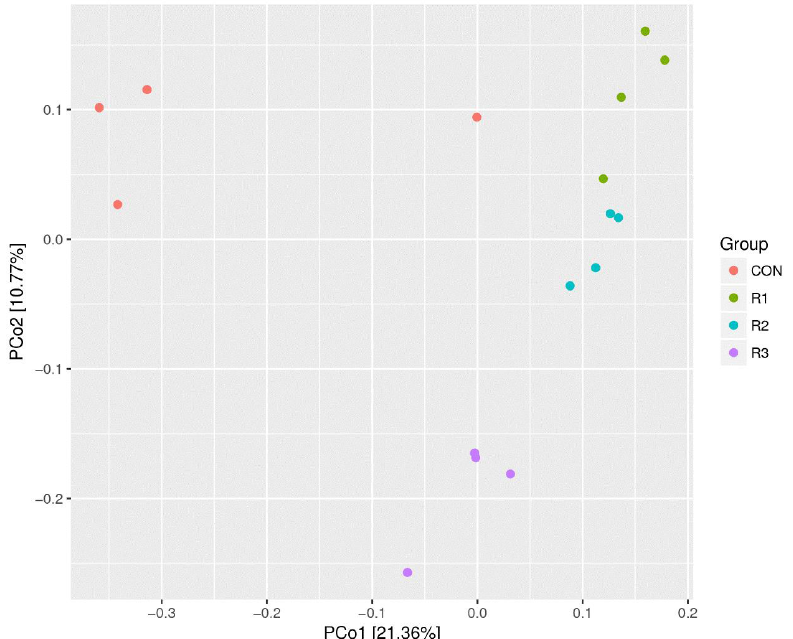
Figure 4. Principal coordinate analysis plot of total microbiota in rumen samples of goats fed with corn and different chop lengths of ramie. CON, corn silage; R1, 1 cm chopped ramie silage; R2, 2 cm chopped ramie silage; R3, 3 cm chopped ramie silage.